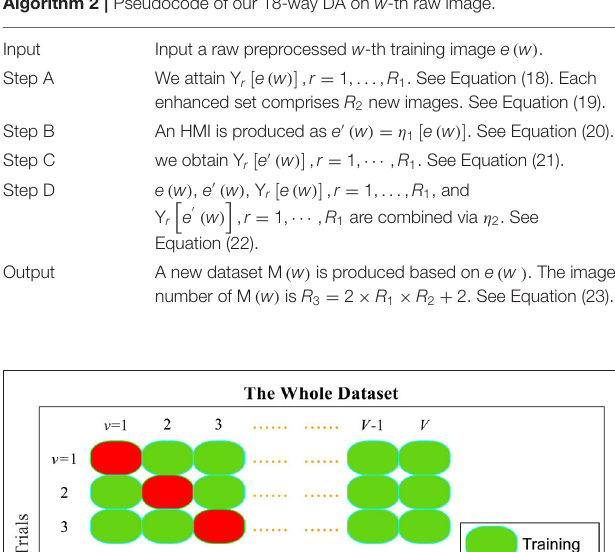
Algorithm 2 | Pseudocode of our 18-way DA on w -th raw image.